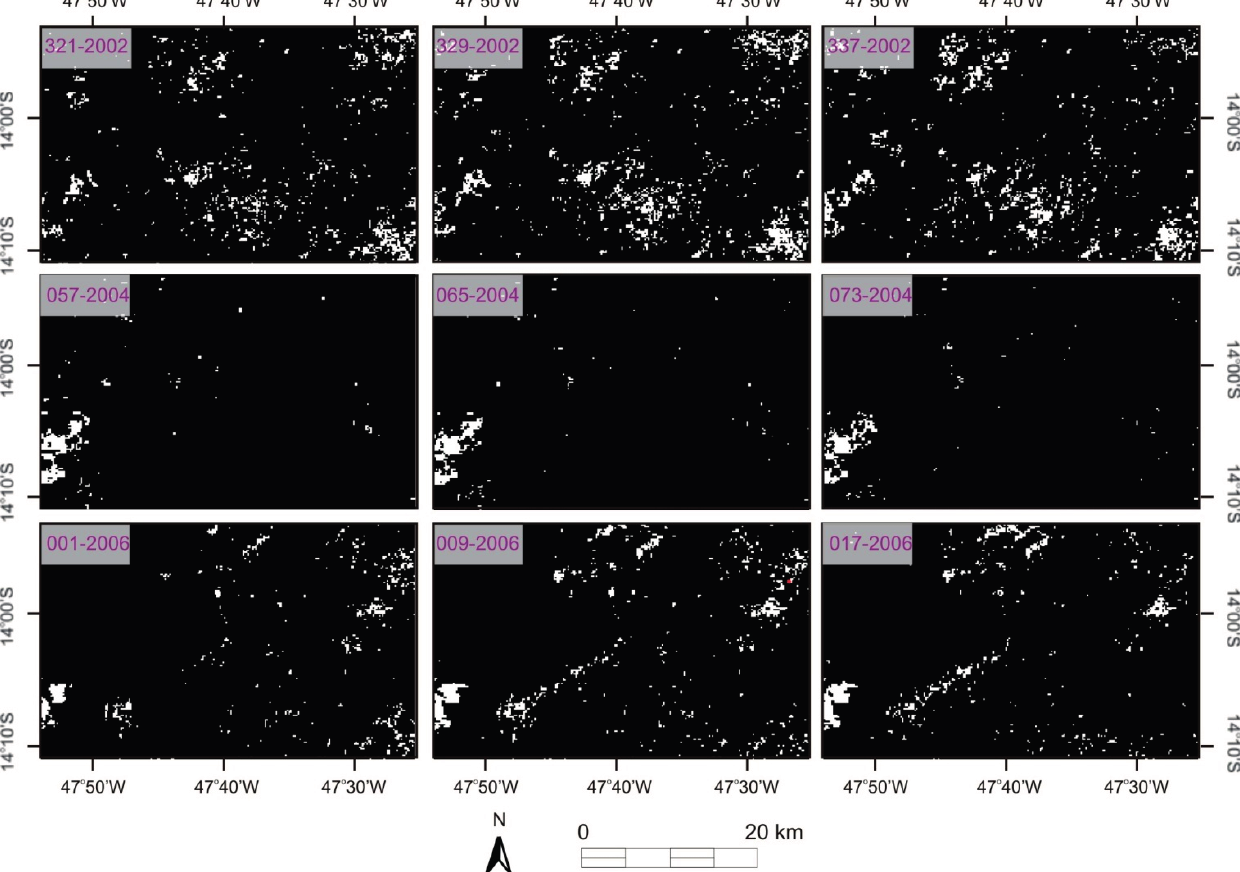
Figure 24. Mask images of the false-positive features with high NBR value. The date is expressed in Julian day and